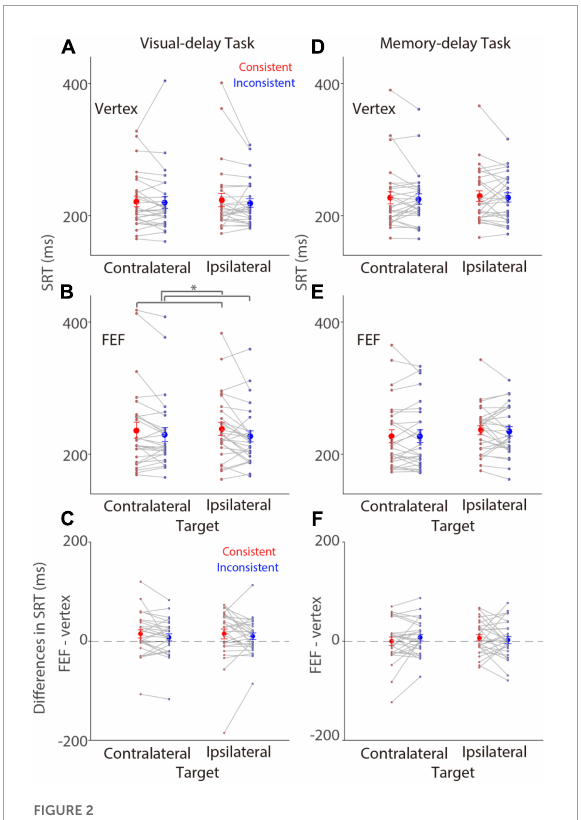
FIGURE2 Modulation of FEF cTBS on saccade reaction time. Modulation of stimulation on SRTs ( N = 28). (A,B) Mean values of SRTs with vertex (A) or FEF (B) stimulation in the visual-delay task. (C) Differences in SRTs between the contralateral and ipsilateral conditions (FEF minus vertex) in the visual-delay task. (D,E) Mean values of SRTs with vertex (D) or FEF (E) stimulation in the memory-delay task. (F) Differences in SRTs between the contralateral and ipsilateral conditions (FEF minus vertex) in the memory-delay task. The large circles and error-bars represent the mean values ± standard error across participants. The dots represent mean value for each participant. *Indicates differences are statistically significant ( p < 0.05). Contralateral: contralateral stimulus condition (left). Ipsilateral: ipsilateral stimulus condition